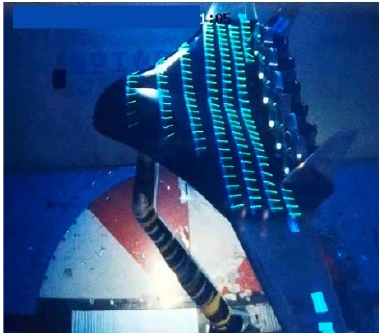
Figure 8. The scaled ‐ down DPD in the wind tunnel experiments.